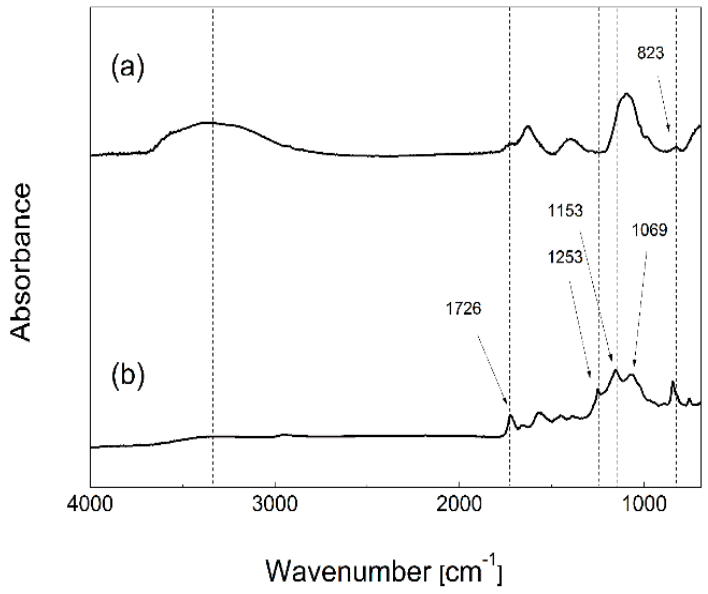
Figure 3. FTIR spectra for original GO ( a ) and GO-PHEMATMS ( b ) particles.